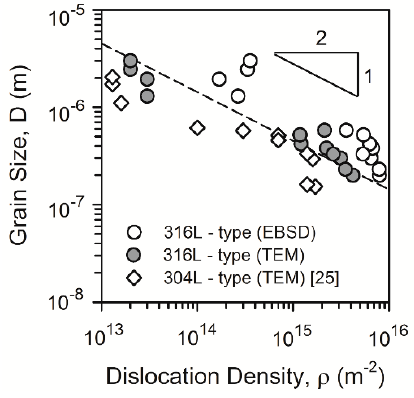
Figure 7. Relationships between the grain size (D) and the dislocation density ( ρ ) in a 316L-type and 304L-type stainless steels processed by cold or warm rolling and subsequent annealing.